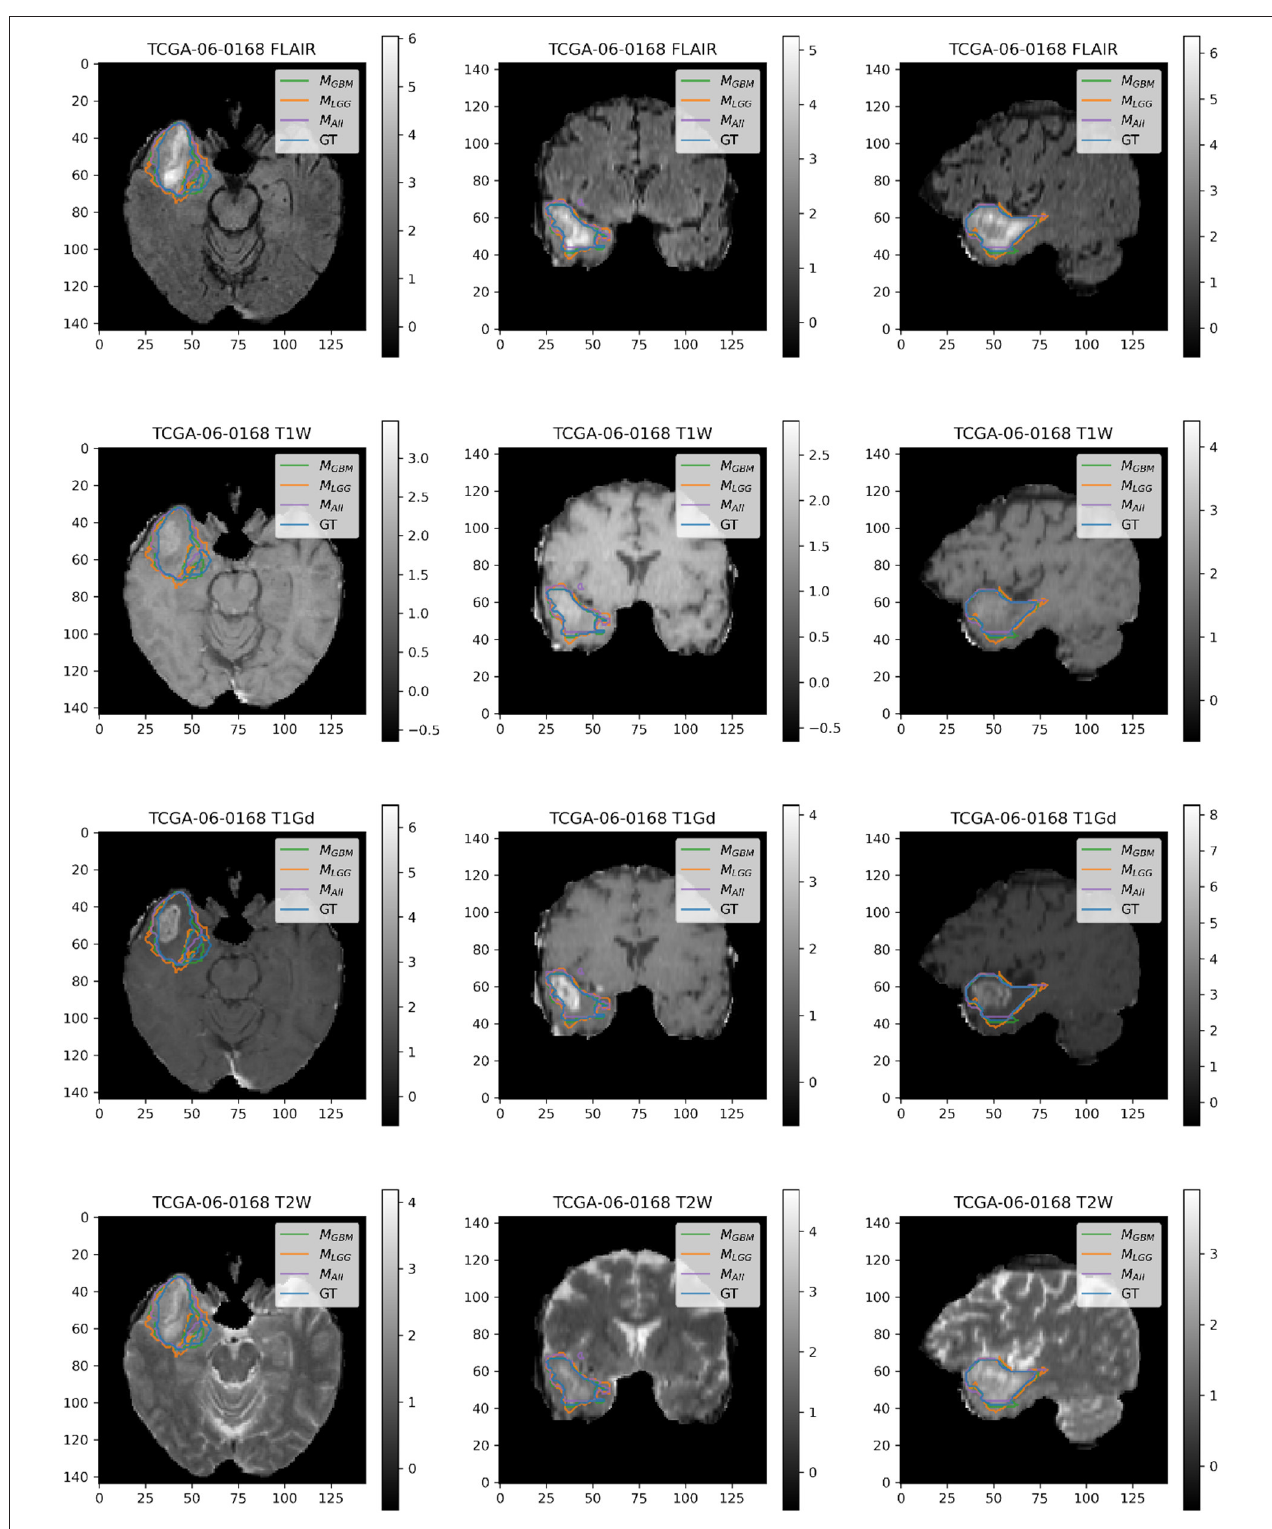
FIGURE 4 | Patient TCGA-06-0168 is diagnosed with GBM in the right temporal operculum. M LGG has low performance on Dice Coefficient (Dice = 0.6847) than M GBM (Dice = 0.8103) and M ALL (Dice = 0.8616). AUROC for all models is high despite unequal performance. The boundary of the edema on FLAIR sequence shows where M LGG over-segments and M GBM under-segments